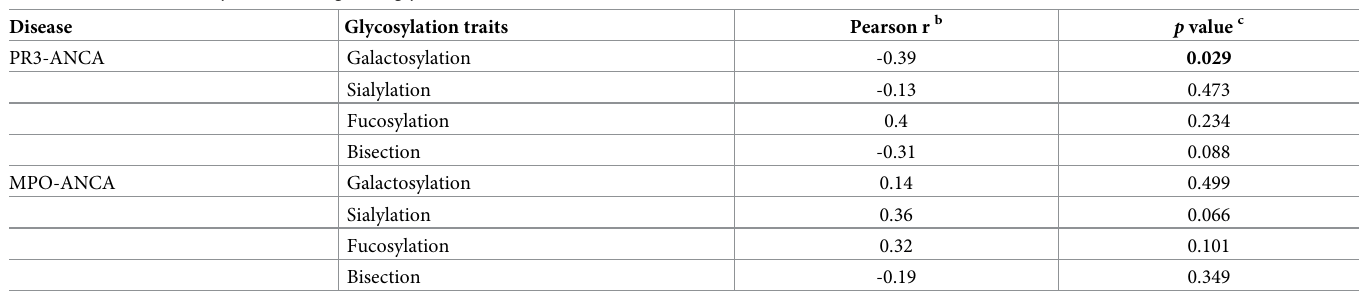
Table 1. Correlation analysis between IgG 1 Fc glycan traits and BVAS a .